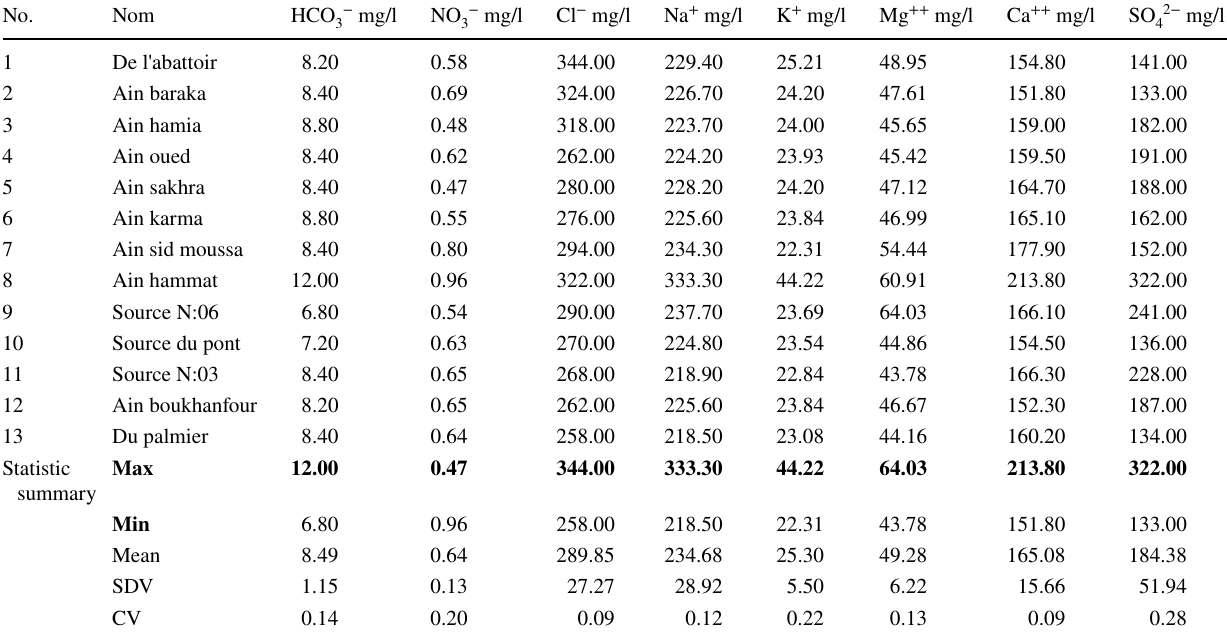
Table 3 Geochemistry of Bouhanifia spring